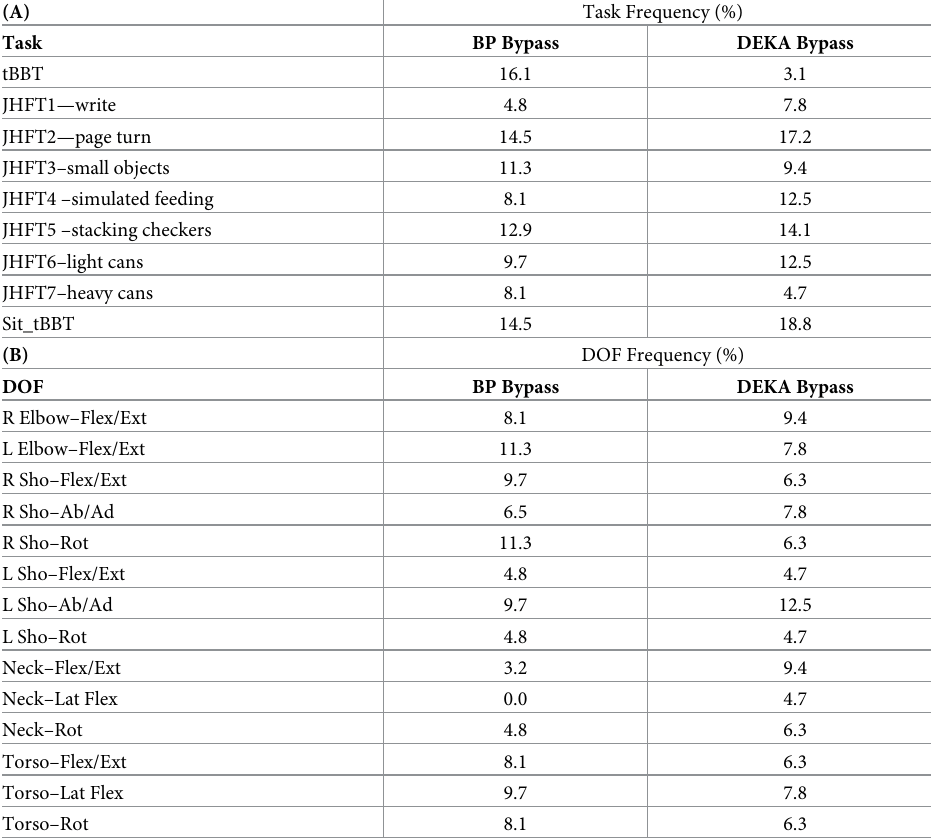
Table 1. Percentage of times a (A) task and (B) DOF were associated with deviations from chance distributions signif- icantly greater than the threshold.